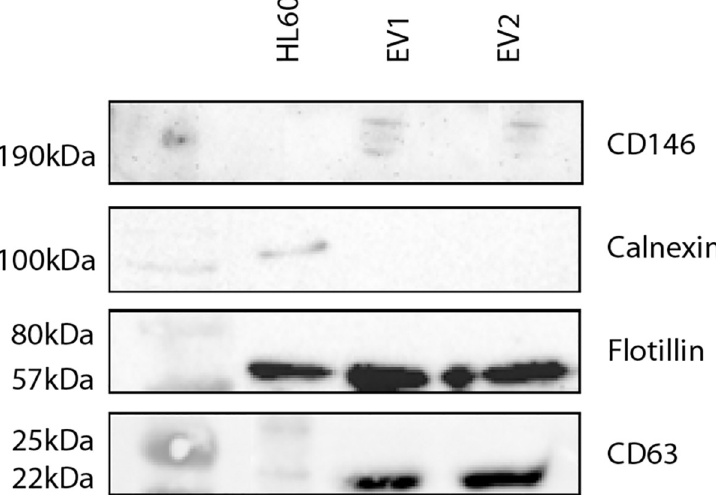
Fig 3. Western blots of EVs isolated from humans undergoing RIPC. Presence of the cytosolic protein flotillin 1, EV marker CD63, endothelial cell marker CD146, and absence of calnexin was analyzed in two representative EV samples extracted of CABG-patients 60 min post-RIPC. HL60 cell lysate was used as a positive control.